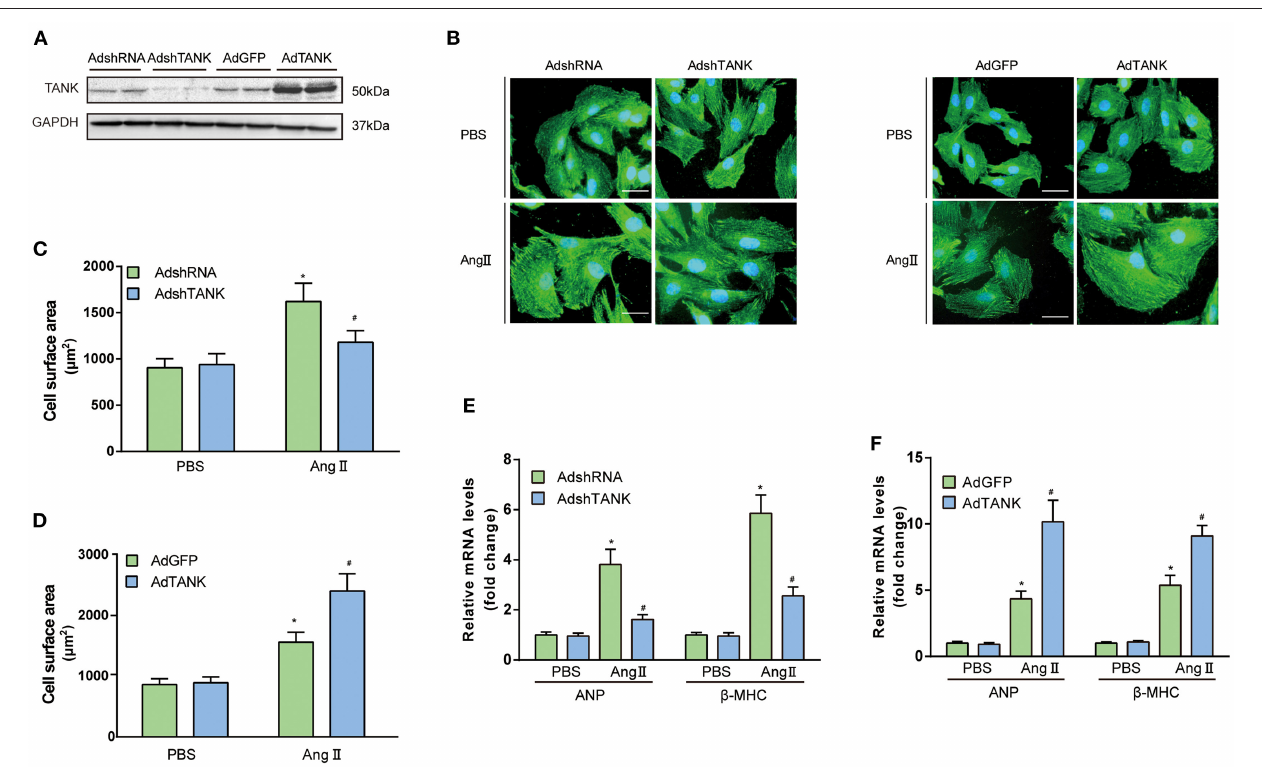
FIGURE 2 | TANK augments the Ang II-induced hypertrophic response of cardiomyocytes. (A) Representative Western blot showing TANK expression in neonatal rat cardiomyocytes (NRCMs) infected with AdshRNA, AdshTANK, AdGFP, and AdTANK. (B) NRCMs were infected with AdshTANK or AdTANK (AdshRNA and AdGFP as control) and treated with Ang II (1 µ mol/L) or PBS for 48h. Sarcomere organization was stained using anti- α -actinin antibodies (green), and nuclei were determined by DAPI staining (blue); scale bar, 20 µ m. (C,D) Quantification of the cell surface area in AdshRNA and AdshTANK (C) or AdGFP and AdTANK (D) treated with PBS or Ang II ( n > 50 cells per experimental group; * P < 0.05 vs. AdshRNA/PBS or vs. AdGFP/PBS; # P < 0.05 vs., AdshRNA/Ang II or vs., AdGFP/ Ang II). (E ,F) Real-time polymerase chain reaction (PCR) analysis of hypertrophic markers atrial natriuretic peptide (ANP) and β -myosin heavy chain ( β -MHC) in AdshRNA and AdshTANK (E) or AdGFP and AdTANK (F) treated with PBS or Ang II for 48h ( n = 3 independent experiments; * P < 0.05 vs. AdshRNA/PBS or vs. AdGFP/PBS; # P < 0.05 vs. AdshRNA/Ang II or vs. AdGFP/Ang II). All the data are presented as the mean ±